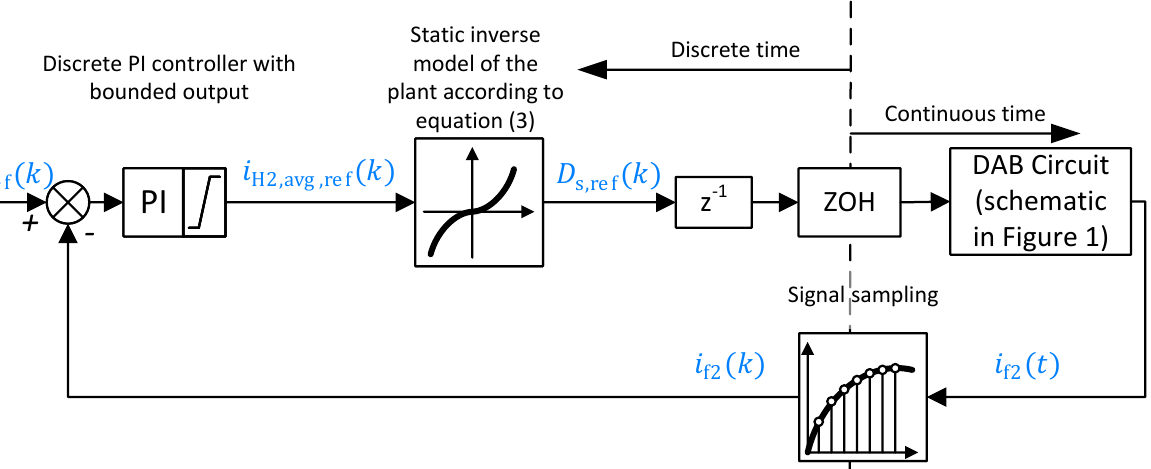
Figure 3. Schematic of the current control